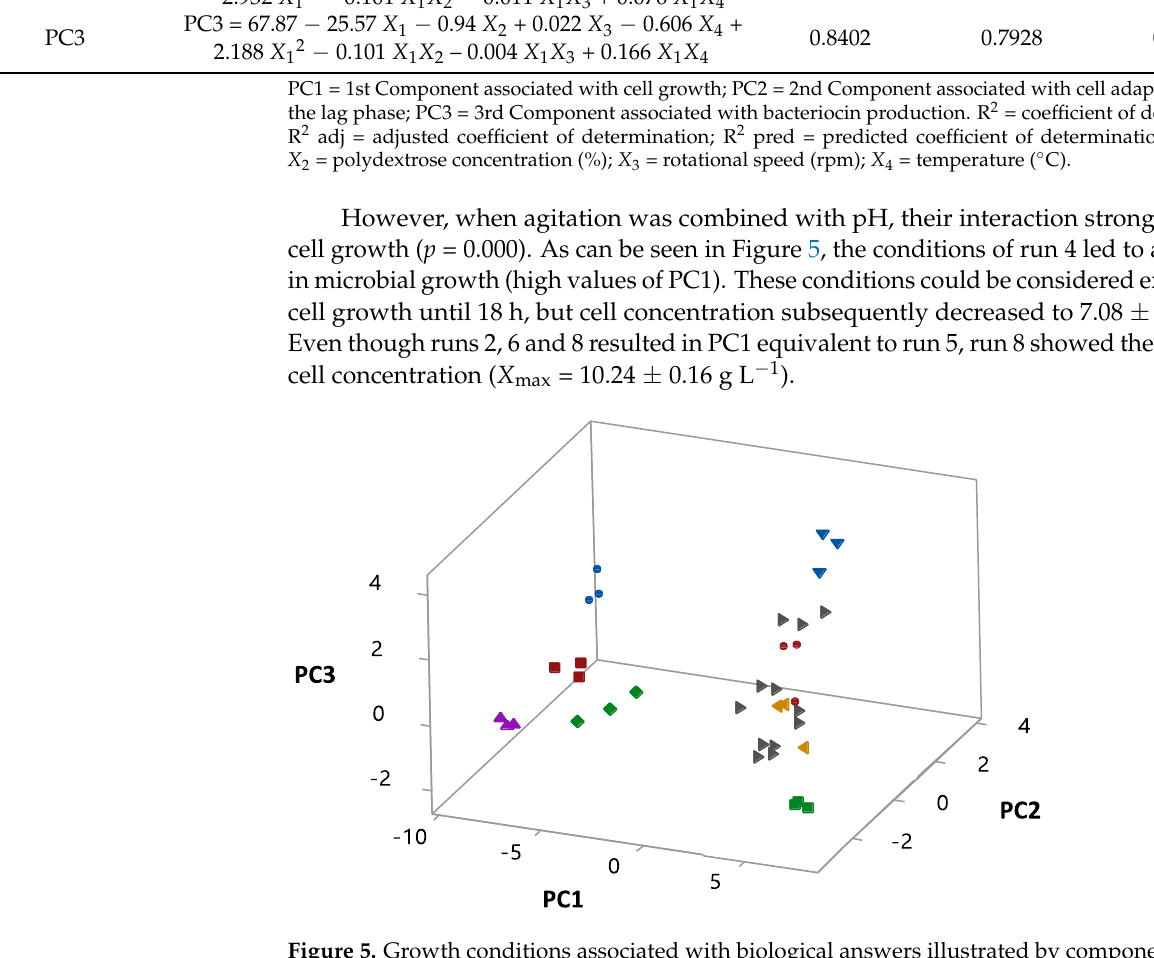
aptation during the lag phase; PC3 = 3rd Component associated with BLIS production. Table 5. Statistical models of Principal Component Analysis (PCA) applied to the three main com- ponents (PC1, PC2 and PC3) of P. pentosaceus fermentation in MRS broth.